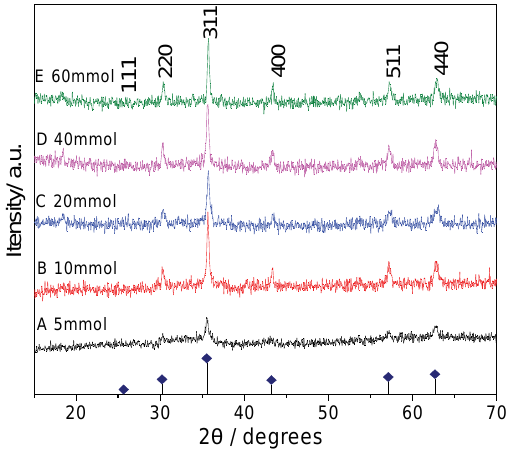
Figure 7. XRD patterns of Fe 3 O 4 obtained with different molar ratio of FeCl 3 ·6H 2 O, A: 0.4 mmol, B: 5 mmol, C: 10 mmol, D: 20 mmol.